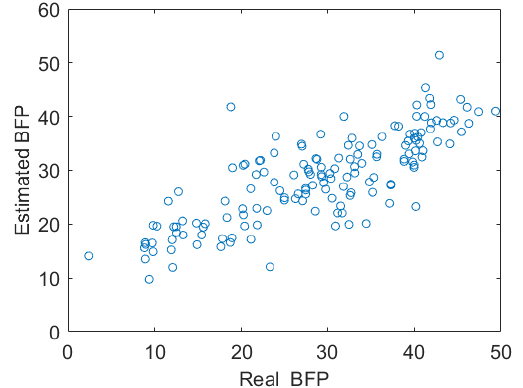
Figure 2. Relation between the real value (BIA) and value estimated by the proposed method. Abbreviations: BFP—body fat percentage.